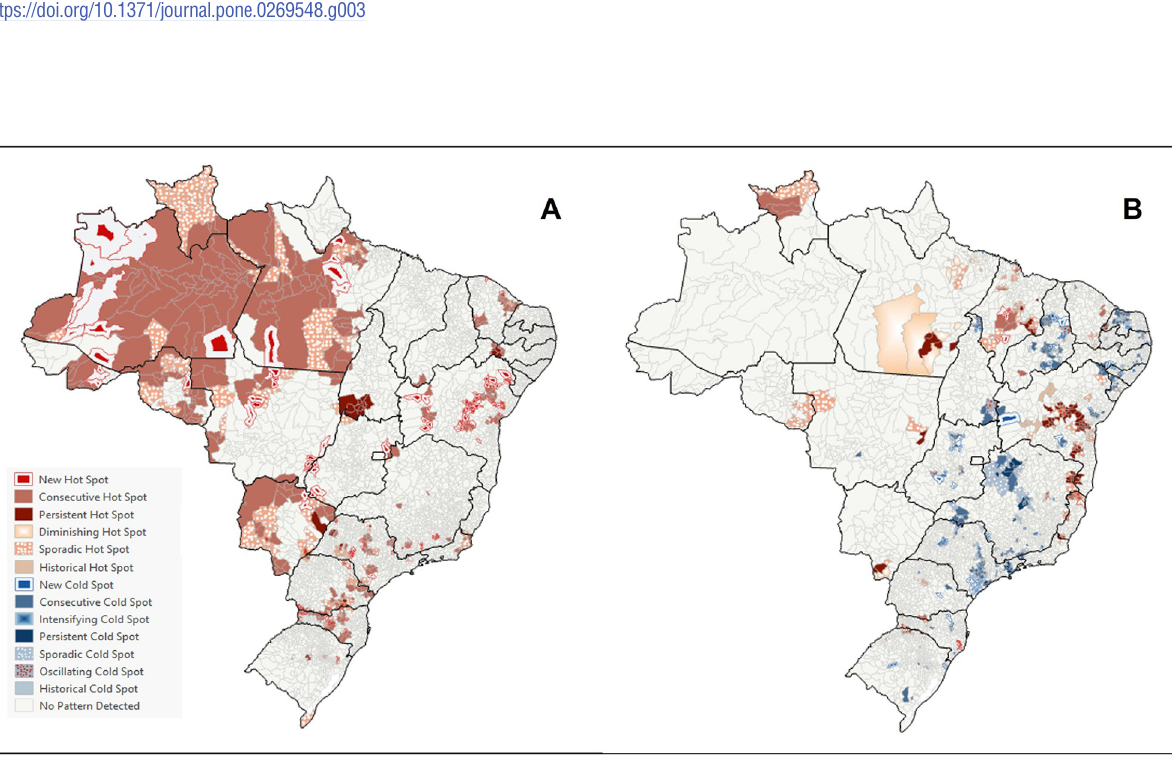
PLOS ONE | https://doi.org/10.1371/journal.pone.0269548 June 9, 2022 8 /